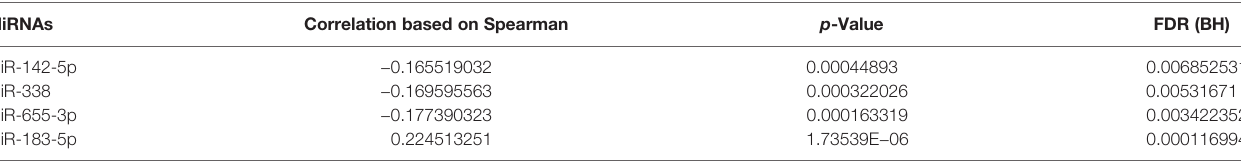
FDR (BH), false discovery rate (Benjamini and